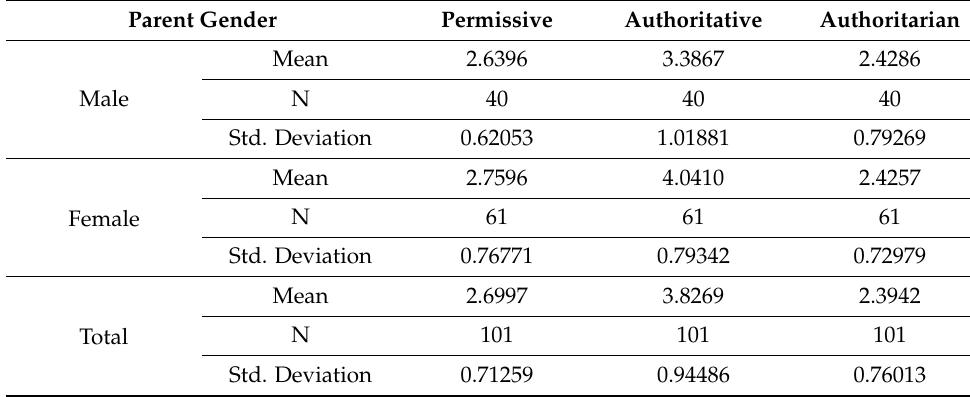
Table 6. Means and standard deviations of parenting style by